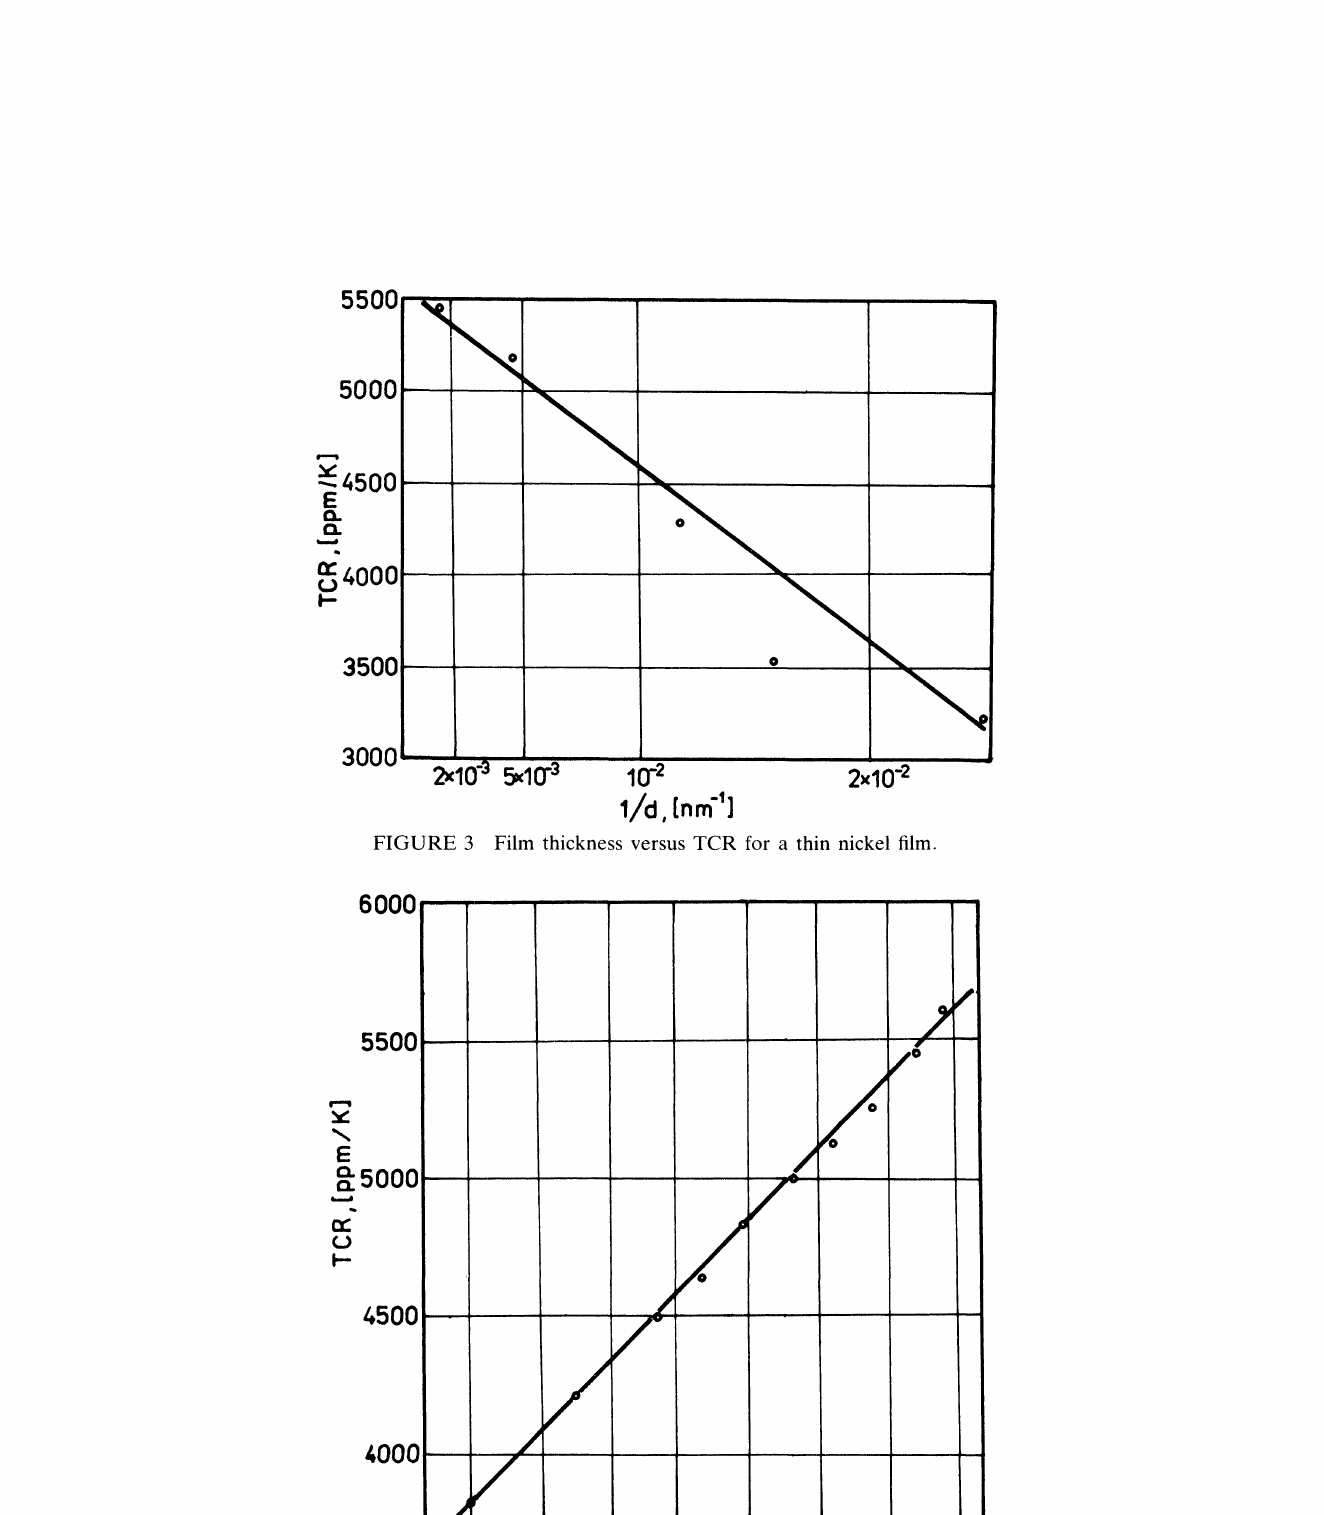
FIGURE 4 Changes in TCR of the sensor with